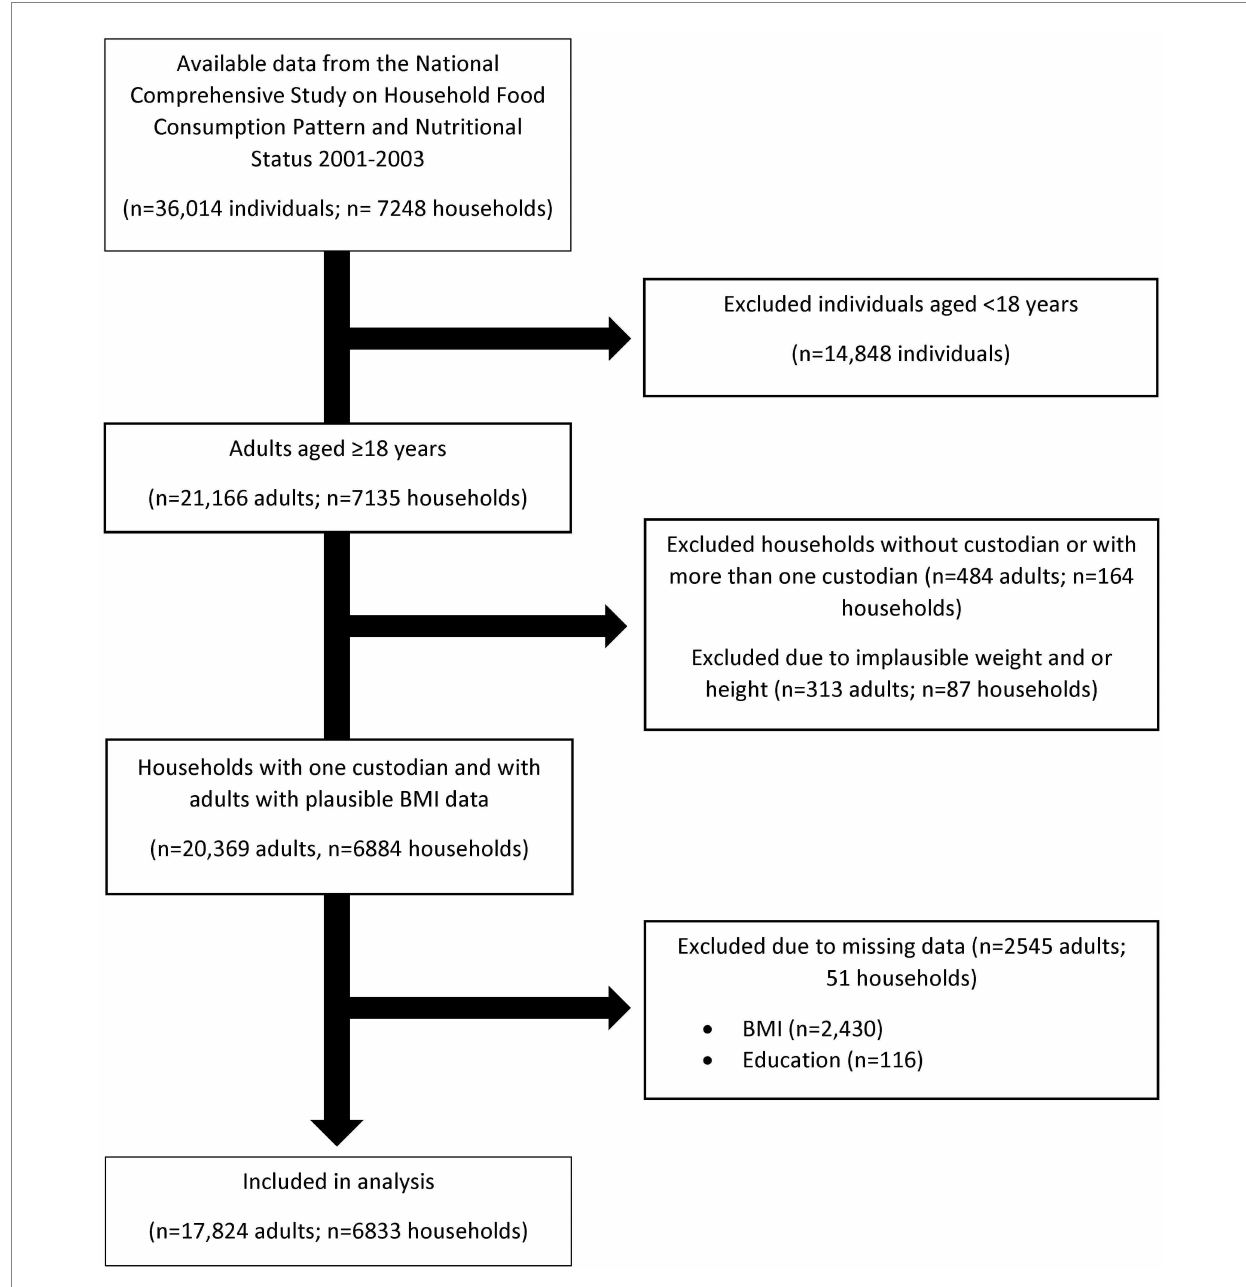
FIGURE 1 Participants flow